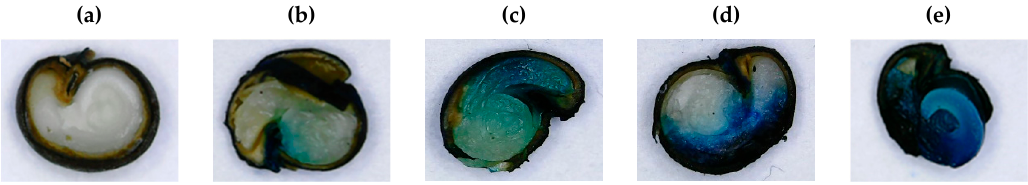
Figure 3. Longitudinal sections of Capparis spinosa seeds. ( a ) Intact seeds before soaking. Seeds previously immersed for 24 h in a methylene blue solution: ( b ) Intact seeds; ( c ) scrapped seeds; ( d ) cracked seeds; and ( e ) broken seeds.